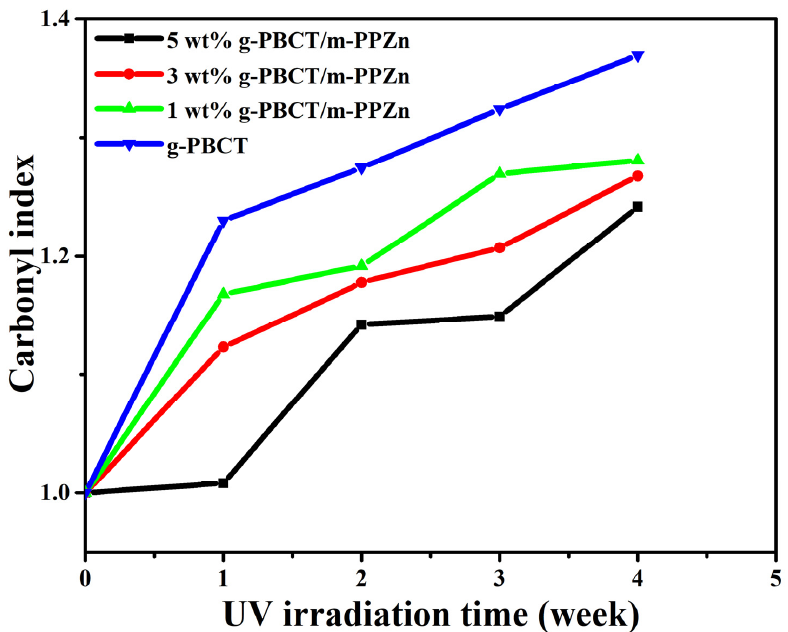
Table 1. Carbonyl index * of g-PBCT/m-PPZn composites after 4 weeks UV irradiation.